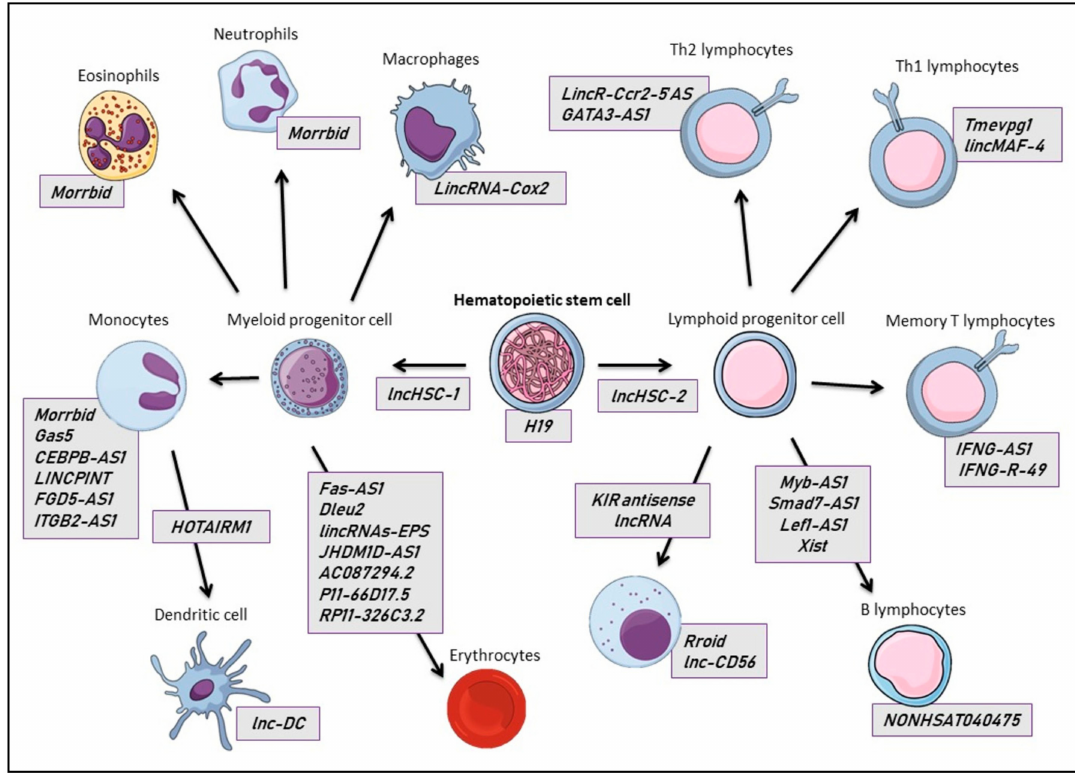
Figure 2. Long non-coding RNAs described in the physiology of mature and progenitor hematopoietic cells, derived from myeloid ( left ) and lymphoid ( right ) differentiation from a hematopoietic stem cell (HSC), in which the lncRNA H19 plays a central role. In the grey rectangles are listed the lncRNAs specifically or differentially expressed in each cell type (rectangles at the side of cells), or lncRNAs involved in the differentiation and maturation of these cells (upon the